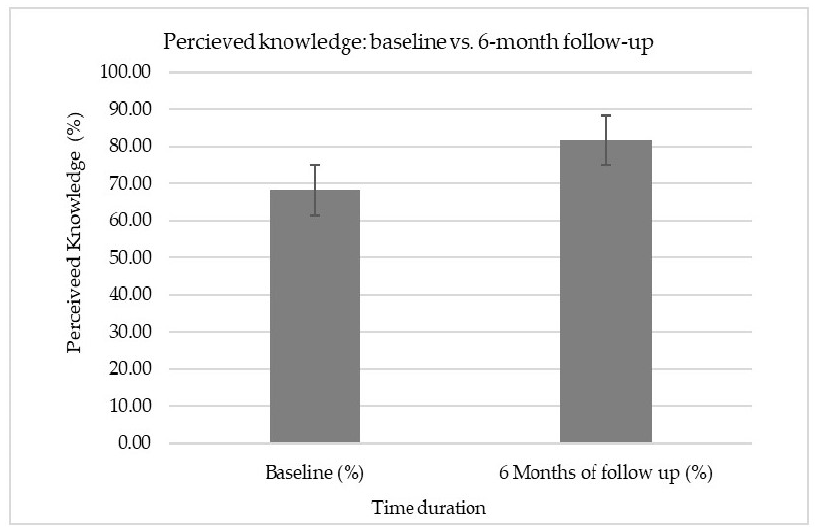
Figure 2. Overall comparison of perceived knowledge scores between baseline and 6-month follow-up.